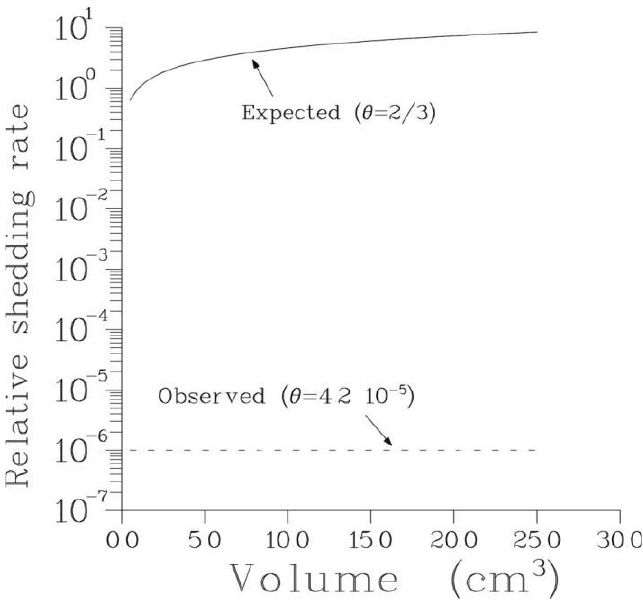
Figure 4. The rate of metastasis shedding Φ θ for patient 1 (assuming α =1 0 − 6 , see Equation (1)) as a function of primary tumor volume v correspon ding to the tumor size Φ (v = Φ c, where c = 10 − 9 cm 3 is taken to represent the average volume of a single tumor cell). The curve labeled “expected (θ = 2/3)” refers to the plausible (yet incorrect) assumption that boundary. The curve labeled “observed (θ = 4.2 ×10 − 5 )” describes the shedding rate for